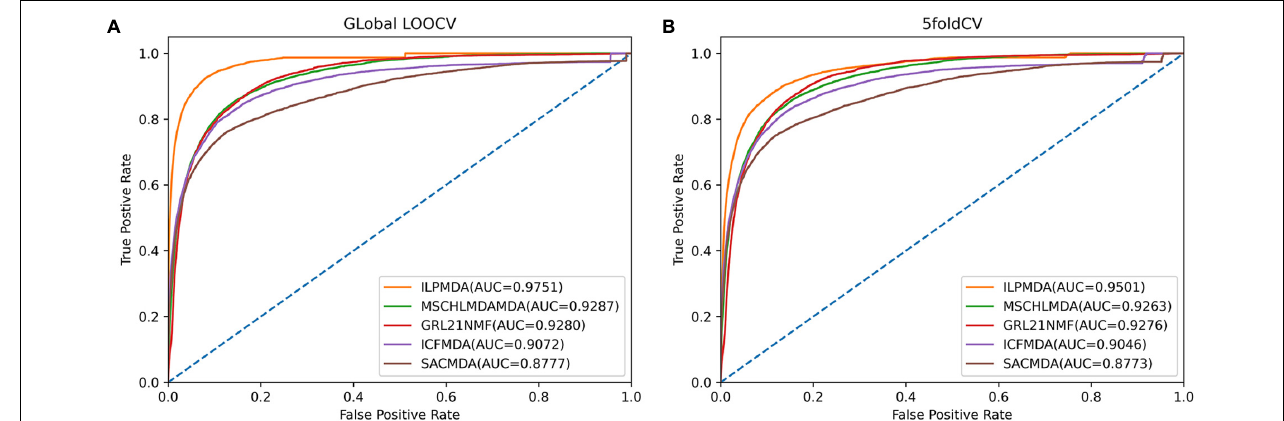
FIGURE 4 | Performance comparisons of ILPMDA with MSCHLMDA, GRL 2 , 1 -NMF ICFMDA, and SACMDA in terms of AUC based on (A) global LOOCV and (B) 5-CV.